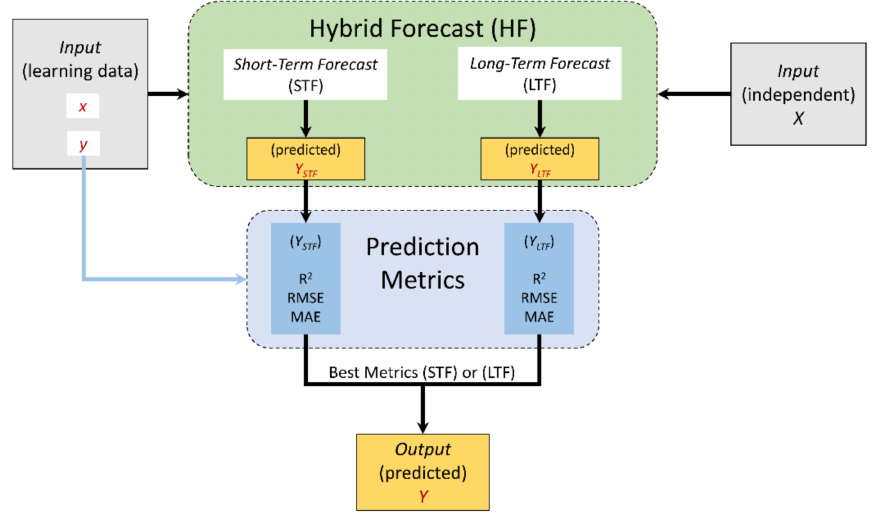
Figure 7. A scheme showing the hybrid forecast (HF)